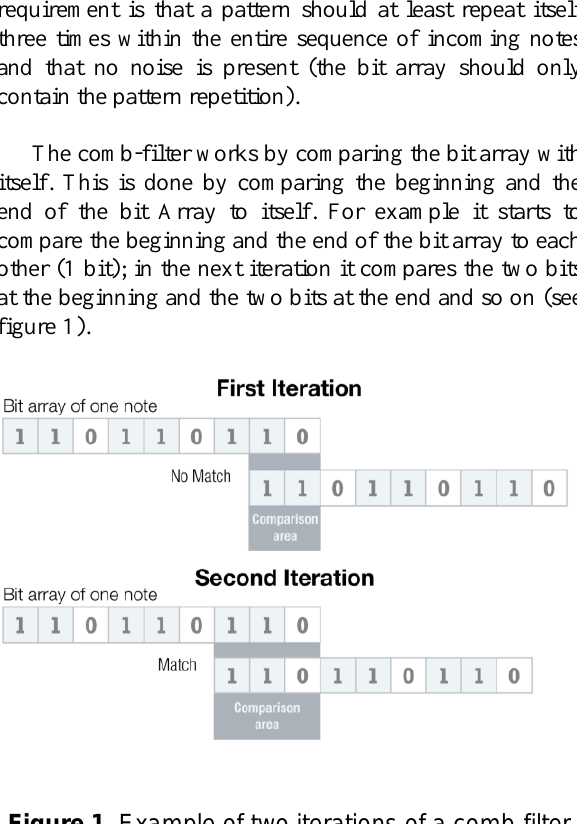
Figure 1. Example of two iterations of a